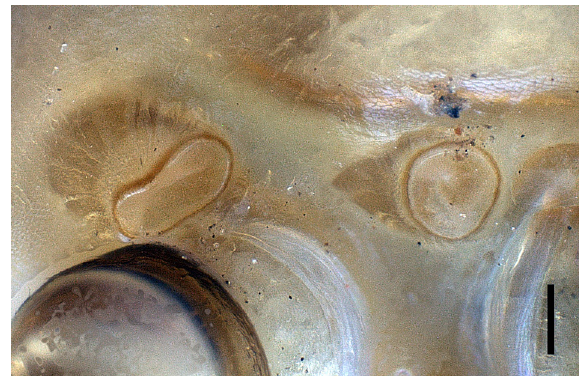
Fig. 14. Pogonosternum adrianae Jeekel, 1982, male, spiracles, midbody ring, left lateral side (NMV K-10719). Scale bar = 0.1